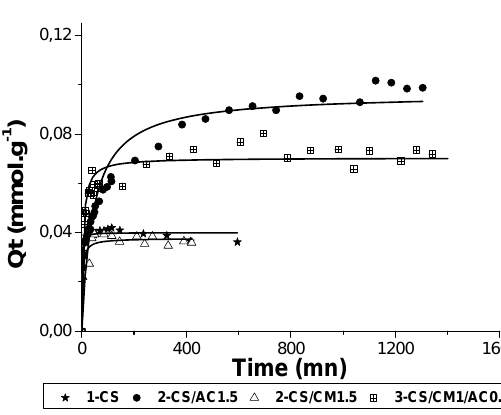
Figure 8. Adsorption kinetic of CBA of pure and hybrid hydrogel CS beads. The continuous lines represent the calculated data using the first-order model.